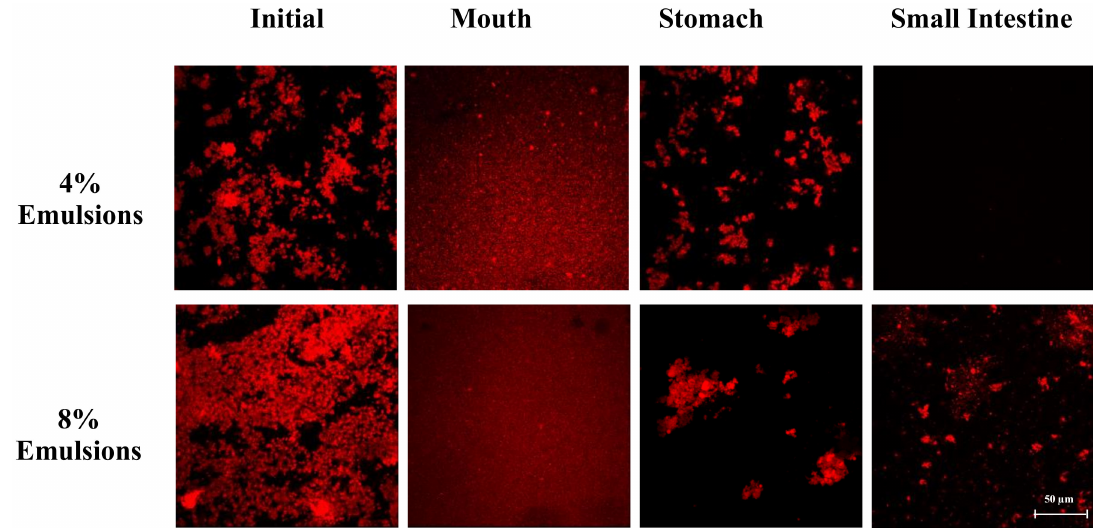
Figure 3. Microstructure of samples with di ff erent lipid contents after they were incubated under di ff erent GIT conditions.